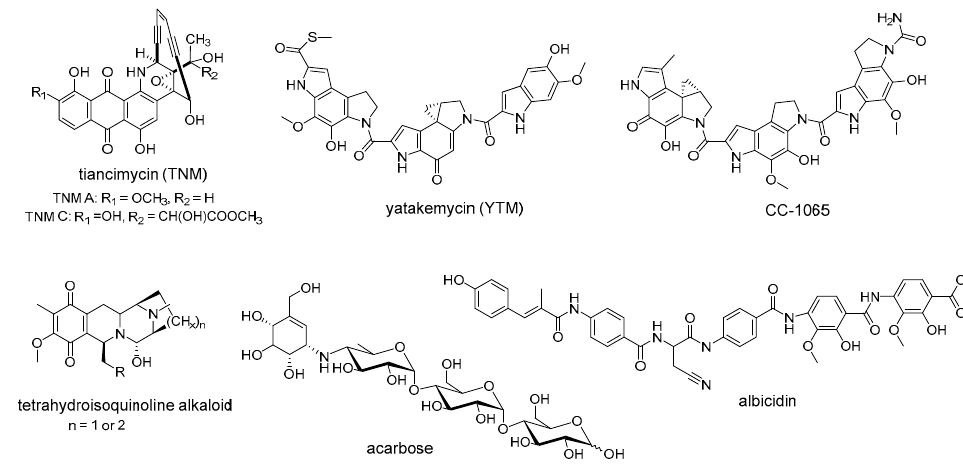
Figure 4. Representative natural products that resistance determinants are widespread in nature.